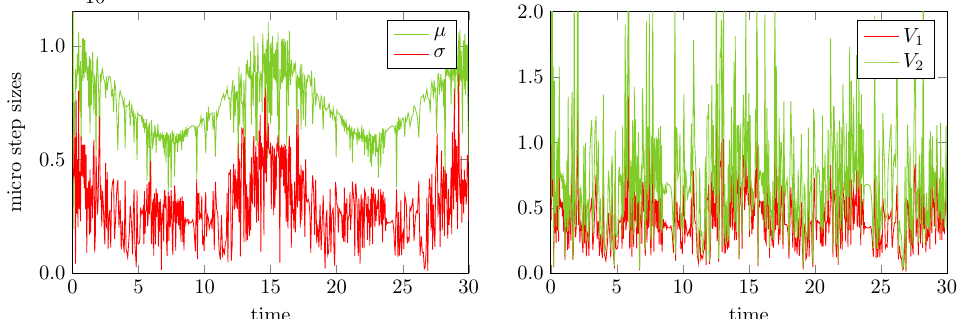
Figure 9. Statistics of the micro step sizes used by an error-controlled macro and micro step adaptive 2nd order multirate generalized-structure additively partitioned Runge-Kutta (MGARK) approach for solving the piston problem. Left : Mean value µ and standard deviation σ of micro step sizes; Right : Coefficients of